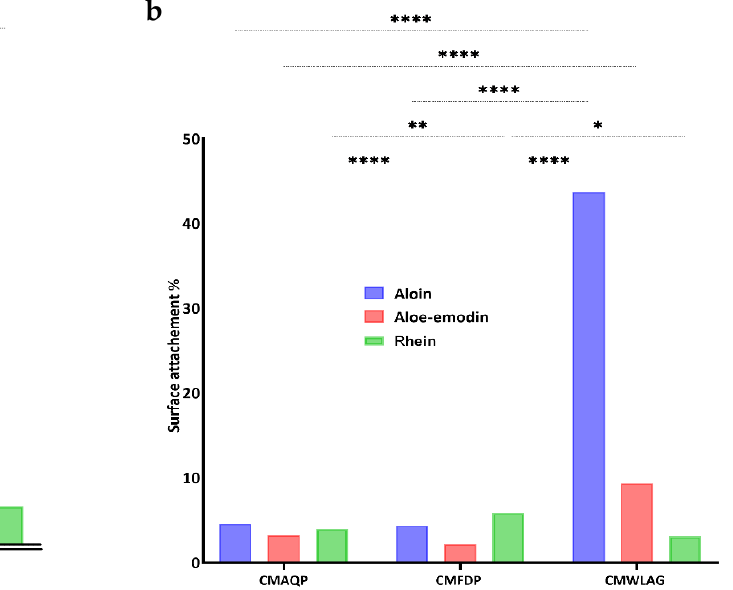
Figure 1. Encapsulation efficiencies (EE%) of anthraquinone-loaded casein micelles (CMAQP, CMFDP, CMWLAG) ( a ) and percentage of surface attachment of anthraquinones ( b ). (Values are from triplicates; the mean and standard deviation are shown. Values significantly different of all spray-dried powders (CMAQP, CMFDP, CMWLAG) when analyzed by two-way ANOVA with Dunnett’s test analysis indicated with asterisks: * p < 0.01, ** p < 0.001, *** p < 0.0003, **** p < 0.0001.).